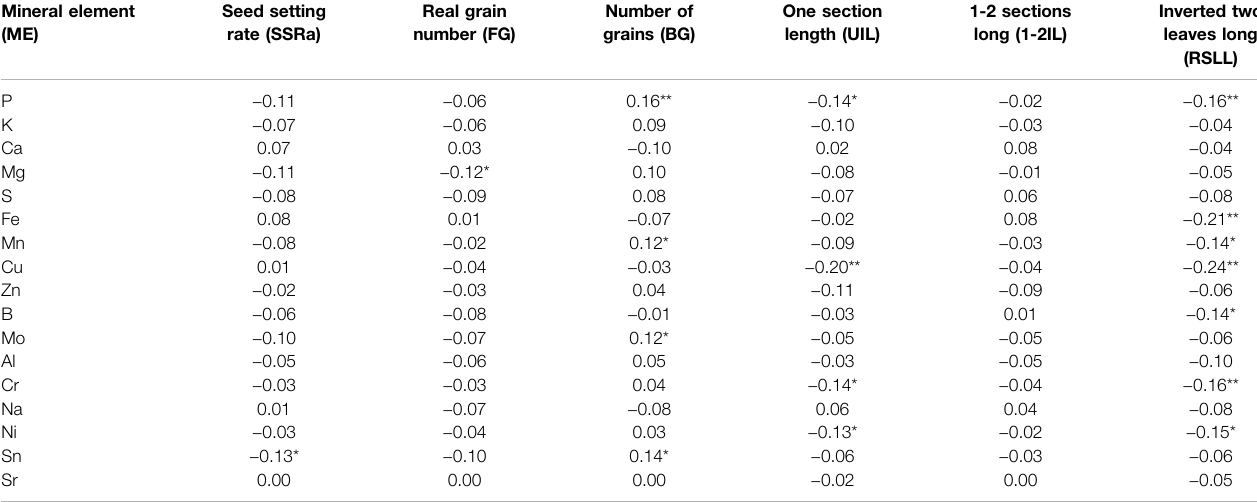
TABLE 4 | Relationship between the total content of 17 mineral elements and cold stress tolerance attributes of Towada brown rice NILs at booting stage. Mineral element (ME)